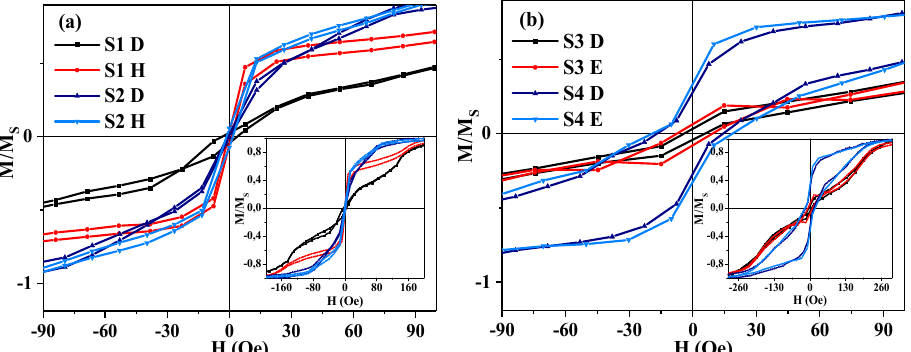
Figure 4. MOKE hysteresis loops taken from the same turning sections of the three-turn ( a ) and six-turn ( b ) Co 75 Fe 10 Ni 2 Si 8 B 5 meander samples.